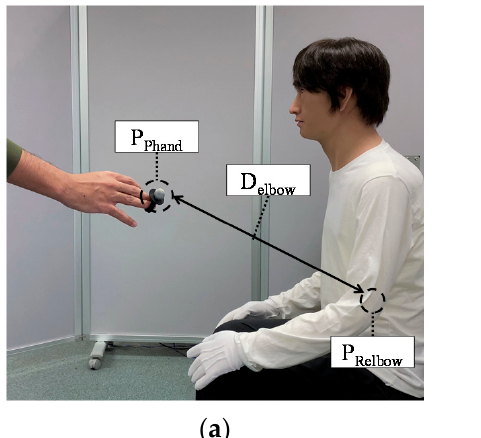
system and three approaching angles: front, left, and right.